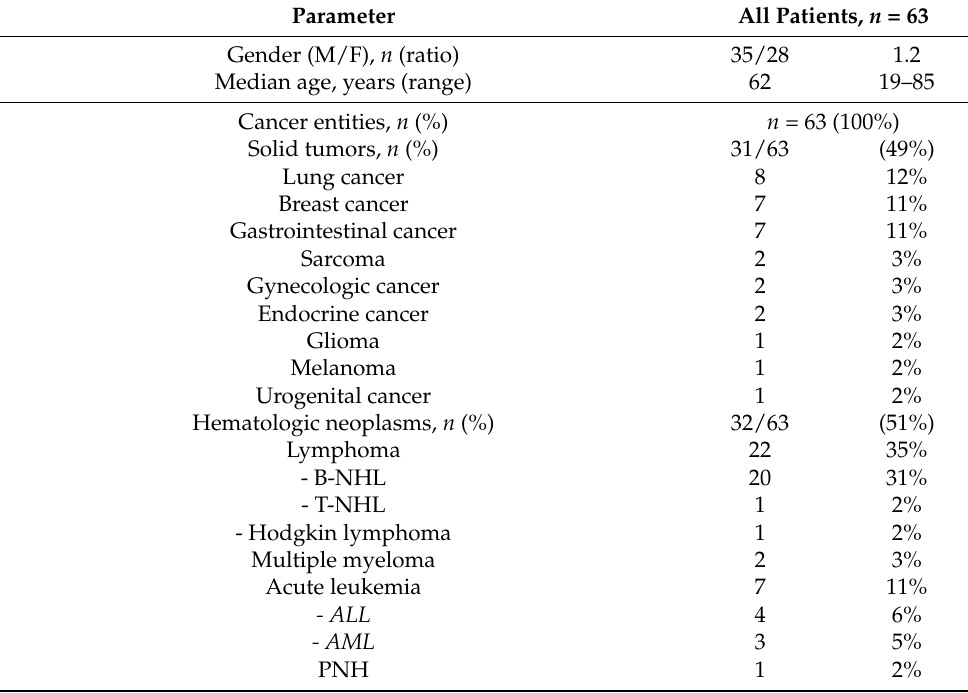
Table 1. Clinical characteristics of 63 cancer patients at the time of SARS-CoV-2 diagnosis. M, male; F, female; n , number; B-NHL, B-cell non-hodgkin lymphoma; T-NHL, T-cell NHL; ALL, acute